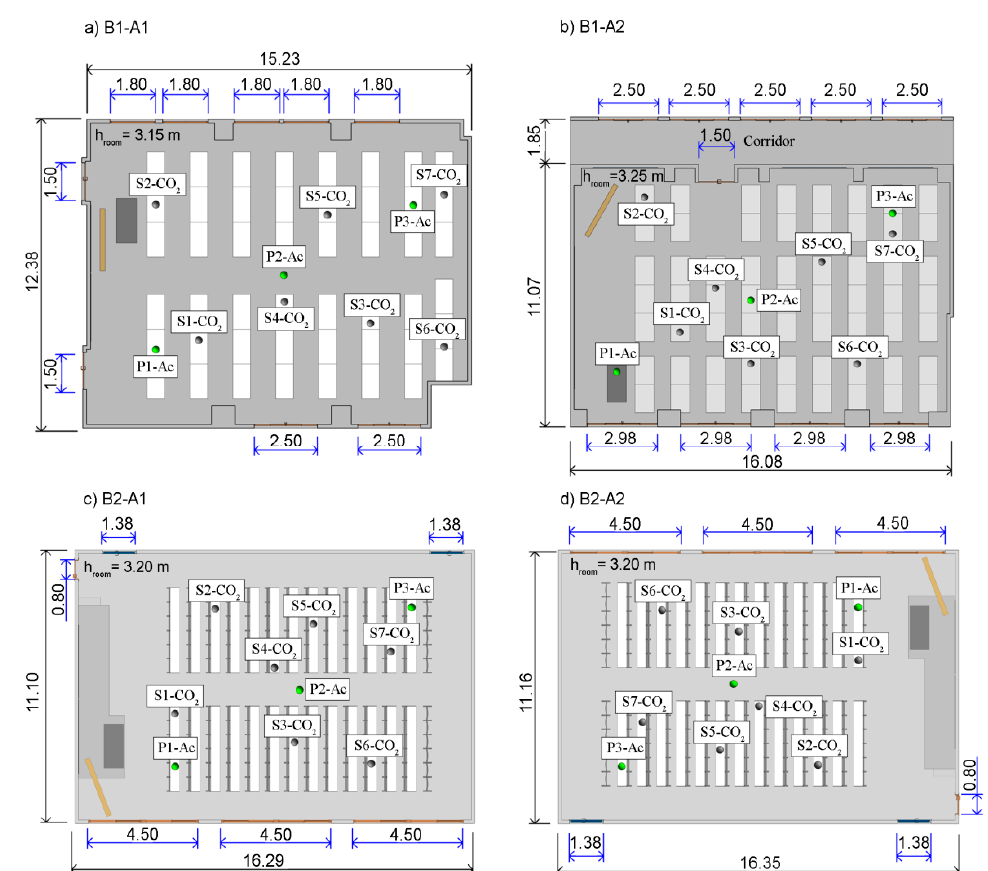
Figure 2. Location of the sensors during the experimental tests performed in each classroom; ( a ) B1-A1 classroom; ( b ) B1-A2 classroom; ( c ) B2-A1 classroom. ( d ) B2-A2 classroom; Blue dimensions indicate size of the openings; Black dimensions indicate sizes of the room; Green spheres indicate the position of the acoustic sensors; Grey spheres indicate the position of CO 2 sensors (dimensions in meters).